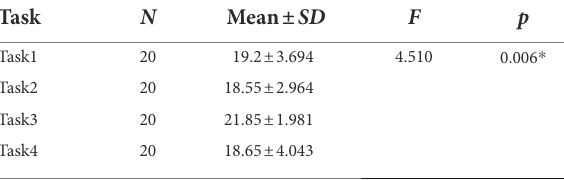
TABLE 4 One-way ANOVA within the ESVD group.